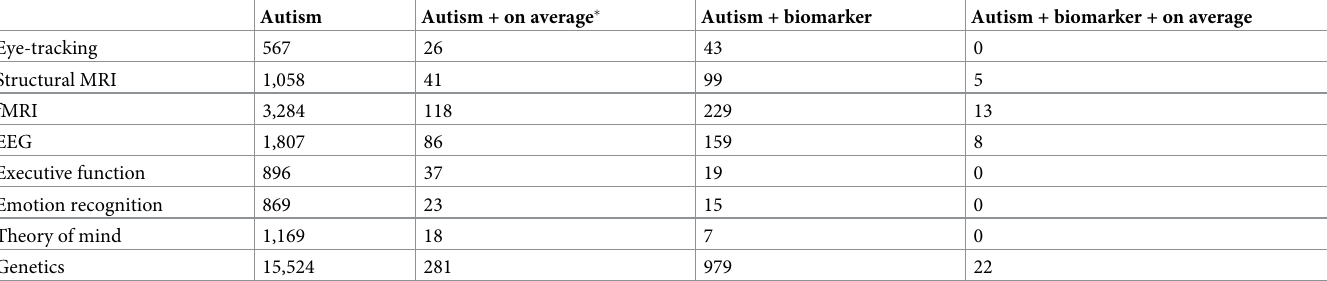
Table 2. Use of terms “on average” and/or “biomarker” in published papers using PubMed search, across